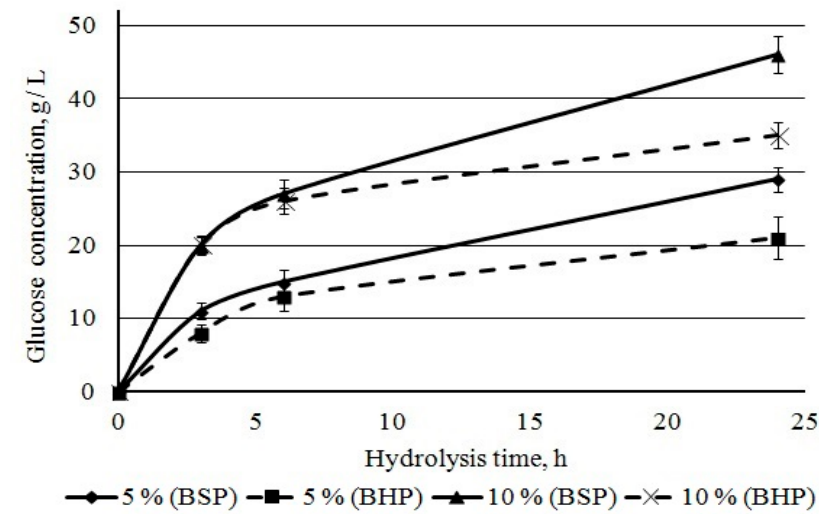
Figure 10. Glucose concentration in pulp hydrolysates during 24 h of hydrolysis.